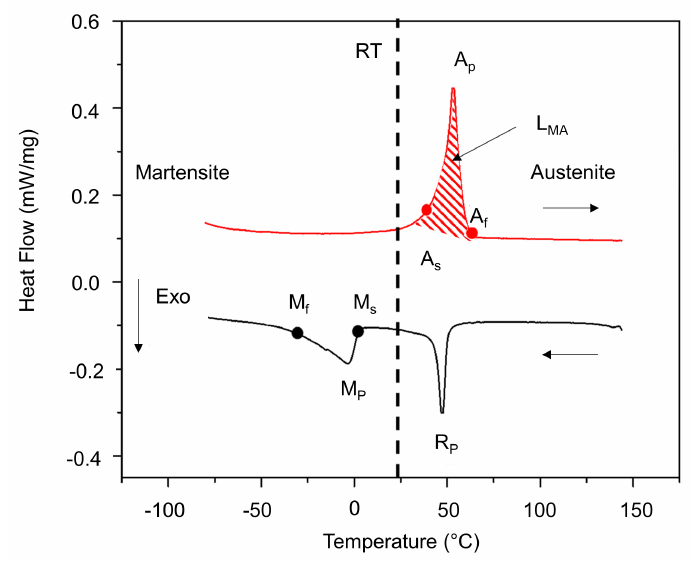
Figure 7. DSC measurement showing phase transformation of NiTi SMA